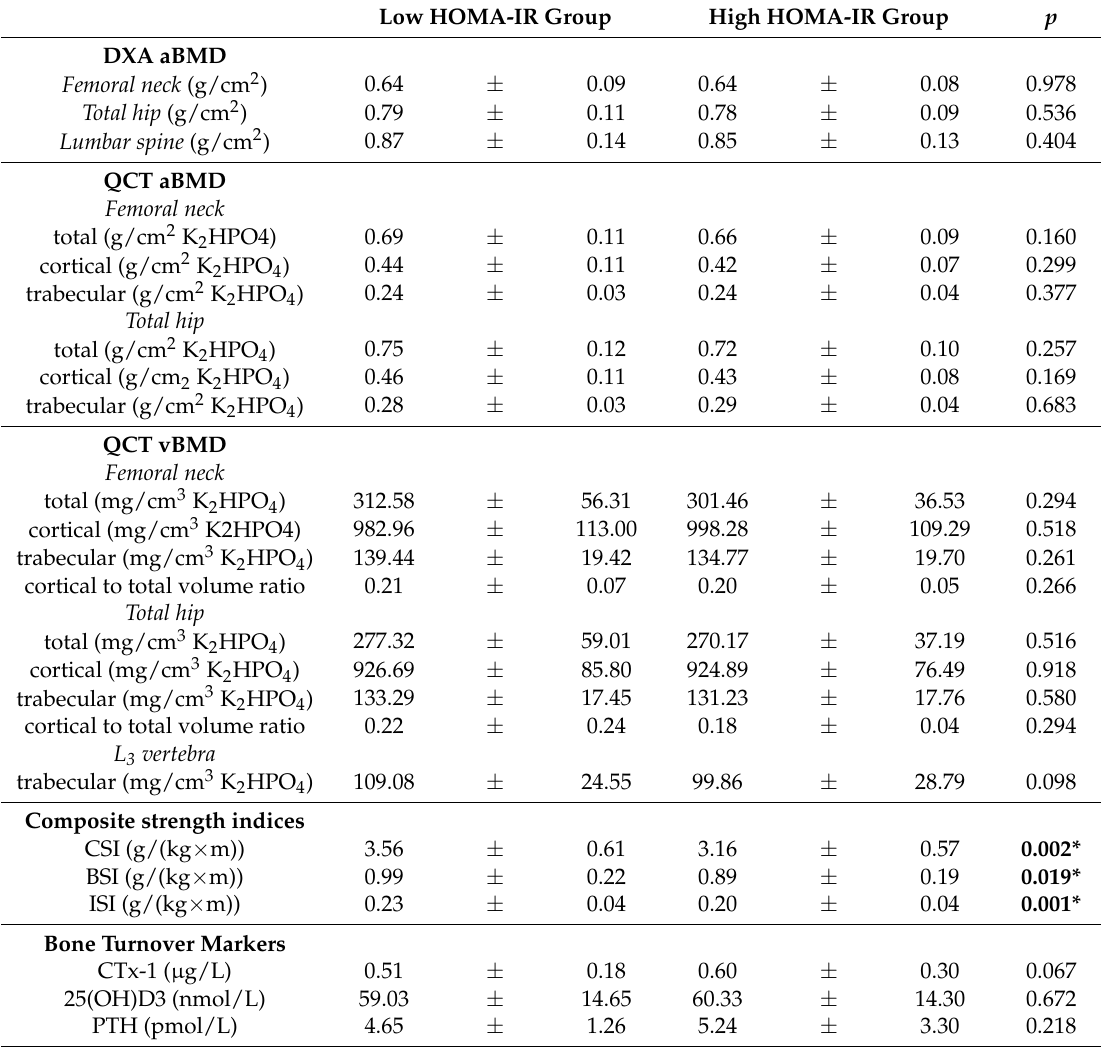
Table 3. Average values and standard deviations of parameters in “low HOMA-IR” and “high HOMA-IR” groups and p -values of two-tailed t -tests between the two groups. Low HOMA-IR Group High HOMA-IR